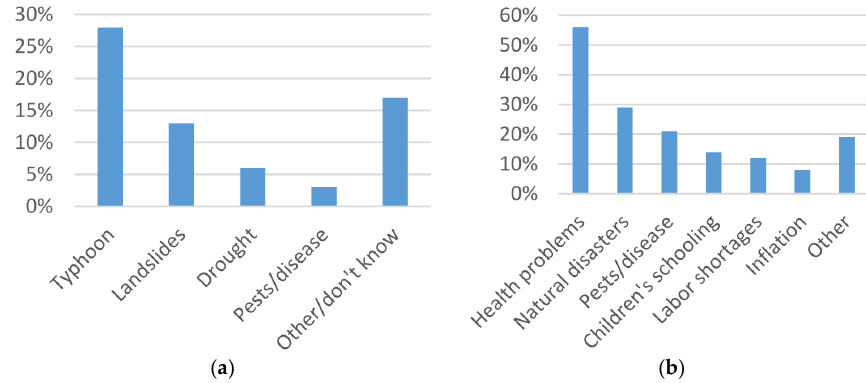
Figure 2. ( a ) The most serious climate/weather risk as identified by households; ( b ) The most serious of all risks as identified by households.